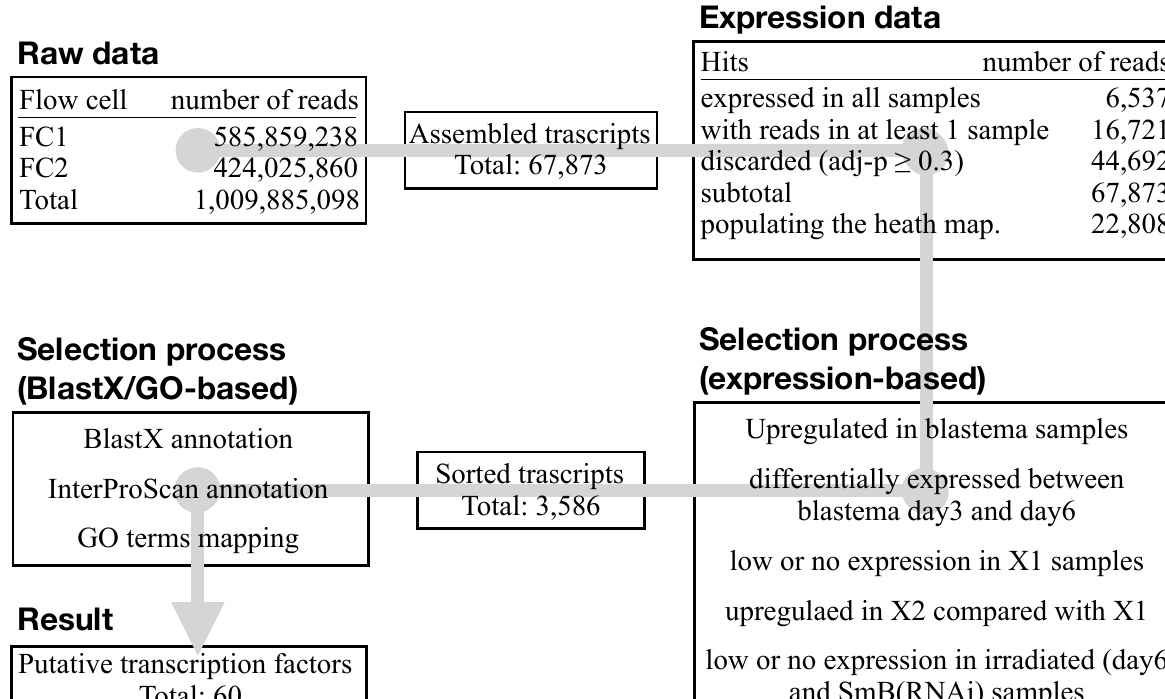
Figure 3. RNA-Seq analysis pipeline. Alongside the core analysis of the raw data (assembly, mapping, and annotation), the complete pipeline also consisted of data sorting. Putative transcription factors active in the blastema were selected according to their relative expression level in the considered samples and their functional annotation (Blastx, InterProScan and GO). A total of 60 putative blastema transcription factors were eventually